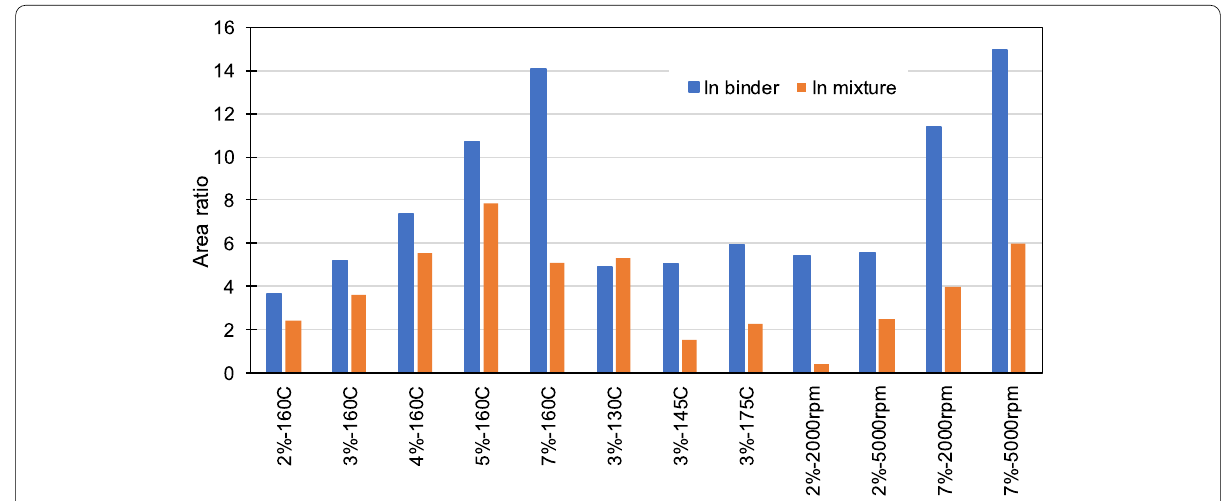
Fig. 12 Comparison of SBS area ratio in asphalt binder and their